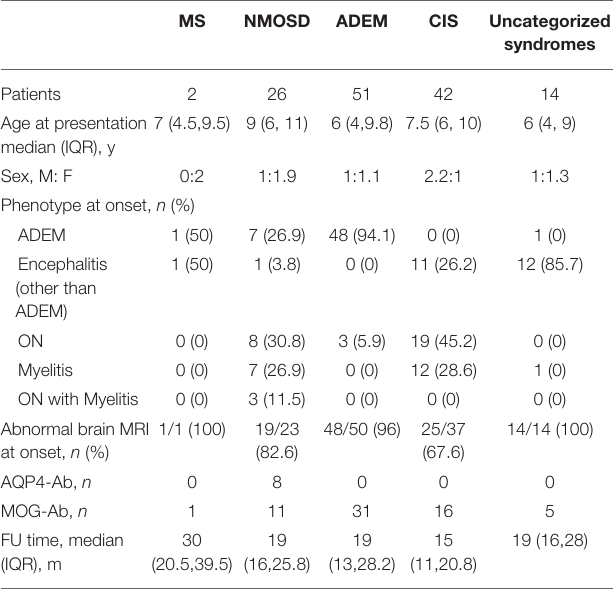
TABLE 1 | Demographic and clinical features of MOG-ab-positive, AQP4-ab-positive and both antibodies negative children according to their final